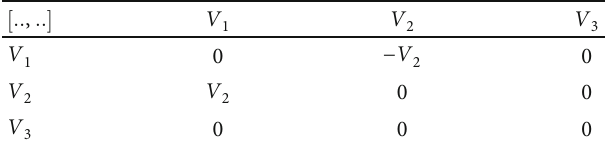
Table 5: Commutator table.